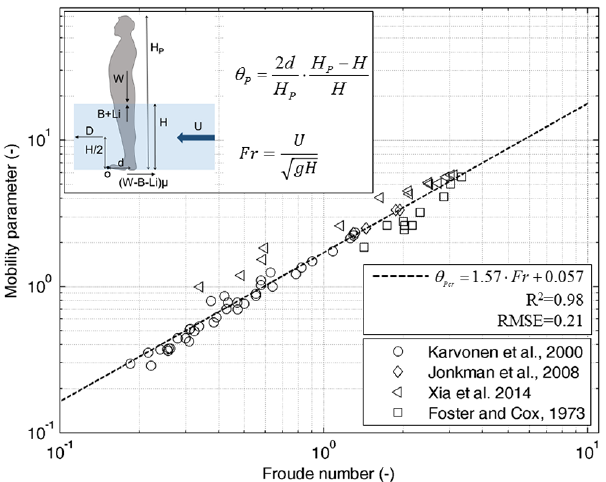
Figure 1. Instability diagram “Dimensionless mobility parameter θ P versus Froude number” for the selected studies (Foster and Cox, 1973; Karvonen et al., 2000; Jonkman and Penning-Rowsell, 2008; Xia et al.,